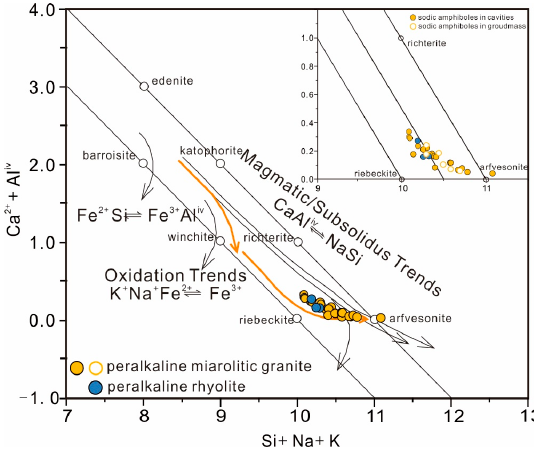
Figure 9. Cationic Si + Na + K versus Ca 2+ + Al IV plots (apfu) for sodic amphibole from the peralkaline granitic dikes compositional trends for Serra da Graciosa Alkaline Association 2, Graciosa Province [62]; fields after Strong and Taylor [61].